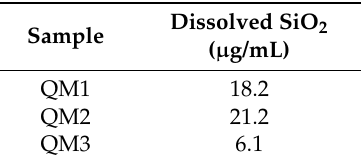
Table 5. Dissolution of silica by the NBR 9848 method.